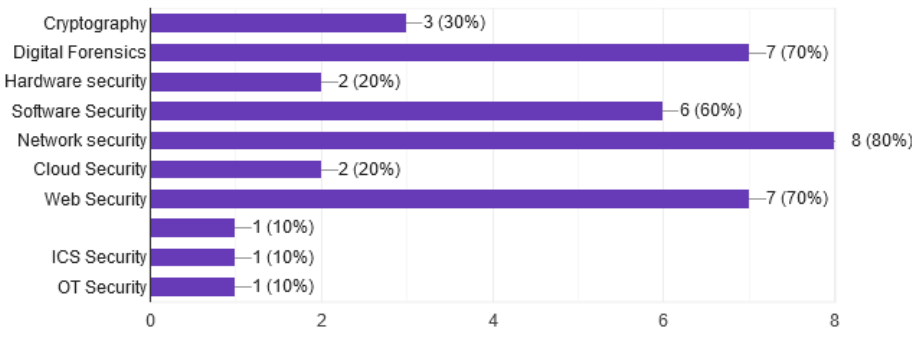
Figure 5. Educational courses of the Cyber